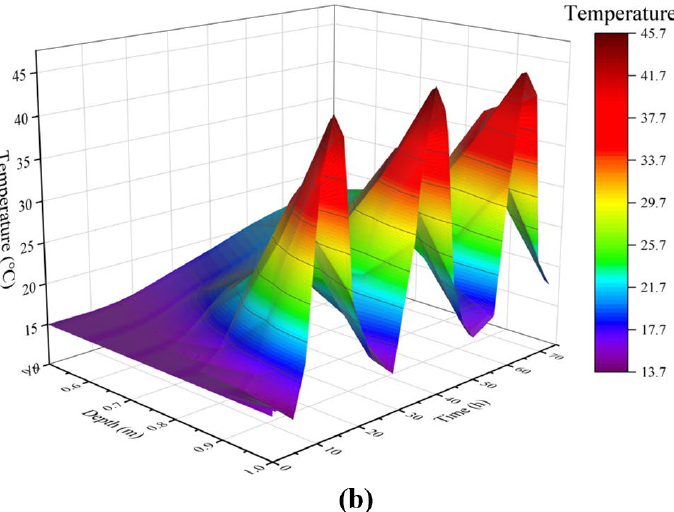
Figure 10. Time-depended temperature distribution in different depth. ( a ) Temperature response of all points from Node_1 to Node_7; ( b ) Temperature response contour of the line where all points are located.